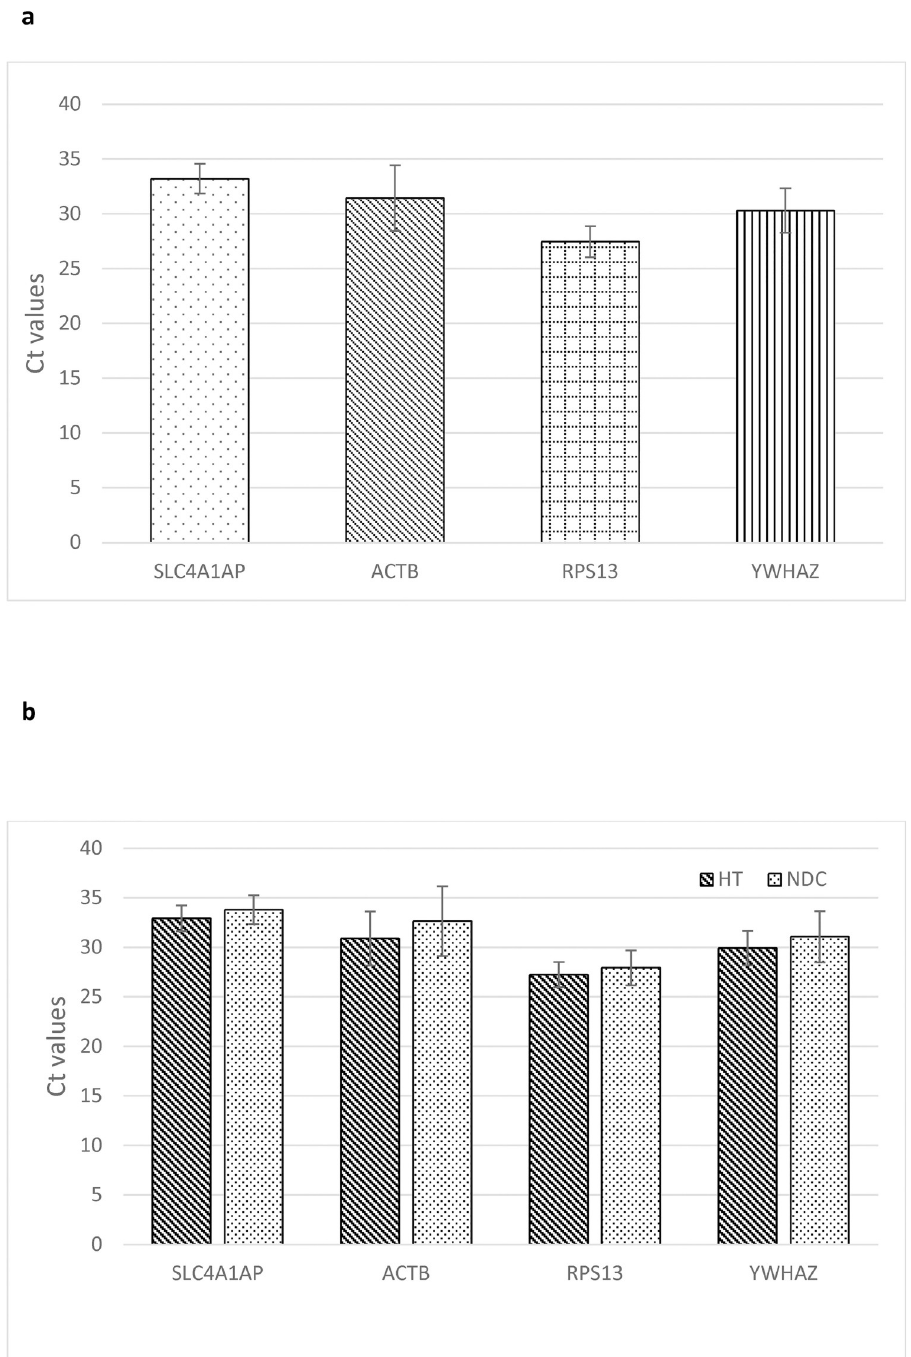
Fig 4. qPCR Ct values for selected reference genes. A) qPCR cycles for all 16 samples. B) qPCR cycles for hypertensive (HP; n = 11) and Non-diseased controls (NDC; n = 5). None of the displayed results was significant at the p < 0,05 level. The y-axis displays Ct values directly. HT = hypertensive group, NDC = non-diseased controls. Data are represented as Mean ± SD.